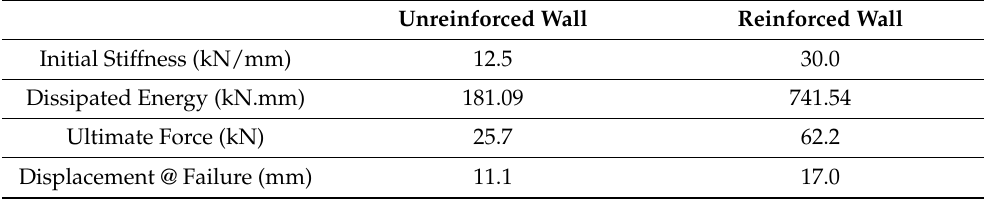
Table 5. Comparison of the in-plane lateral performances between the tested